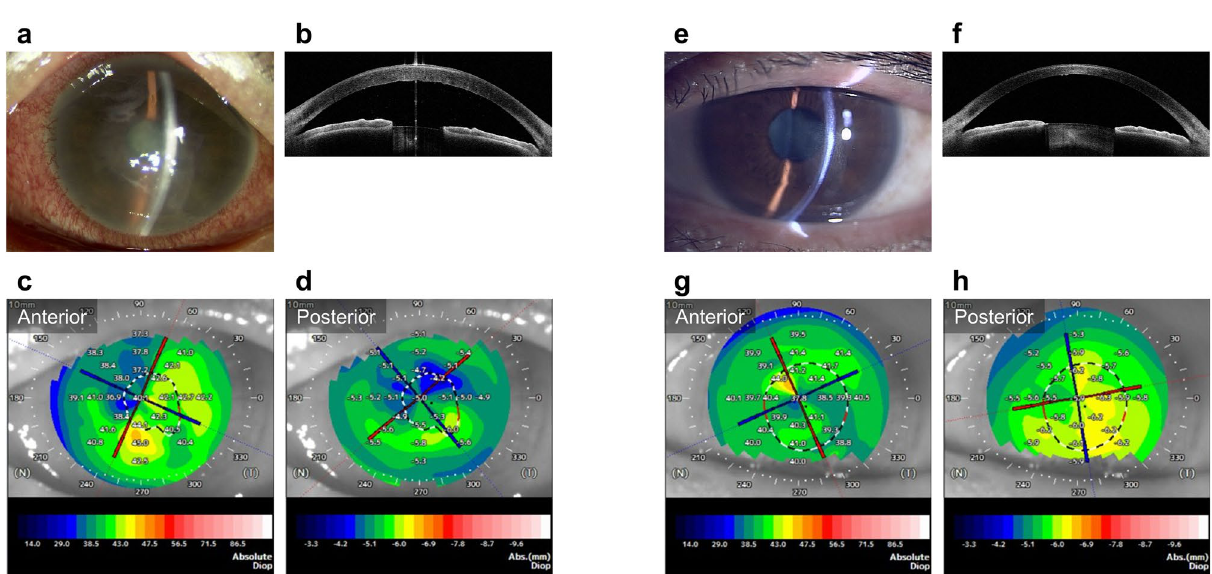
Figure 3. Slit-lamp and anterior segment optical coherence tomography images of a representative case of bacterial keratitis. ( a,b ) Before treatment, corneal infiltration and edema are observed near the centre of the cornea. ( c,d ) The corneal higher-order aberration (HOA) (total, 6 mm) is 3.20 μm, and the logMAR best spectacle-corrected visual acuity (BSCVA) is 1.80. ( e–h ) The patient is treated with antibiotic eye drops and healed with a mild scar near the centre of the cornea. However, the corneal HOA (total, 6 mm) after treatment is 2.41 μm, and the logMAR BSCVA is only 0.40 due to irregular